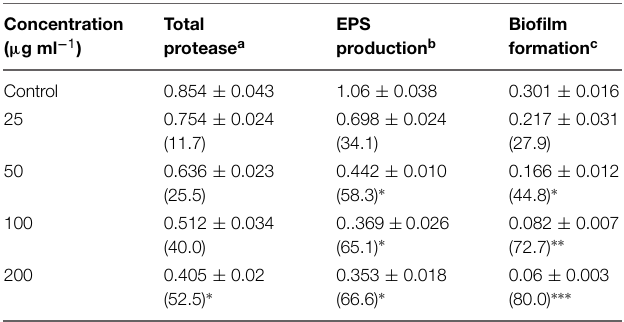
TABLE 5 | Effect of sub-MICs of menthol on inhibition of quorum sensing regulated virulence factors in A. hydrophila WAF-38.